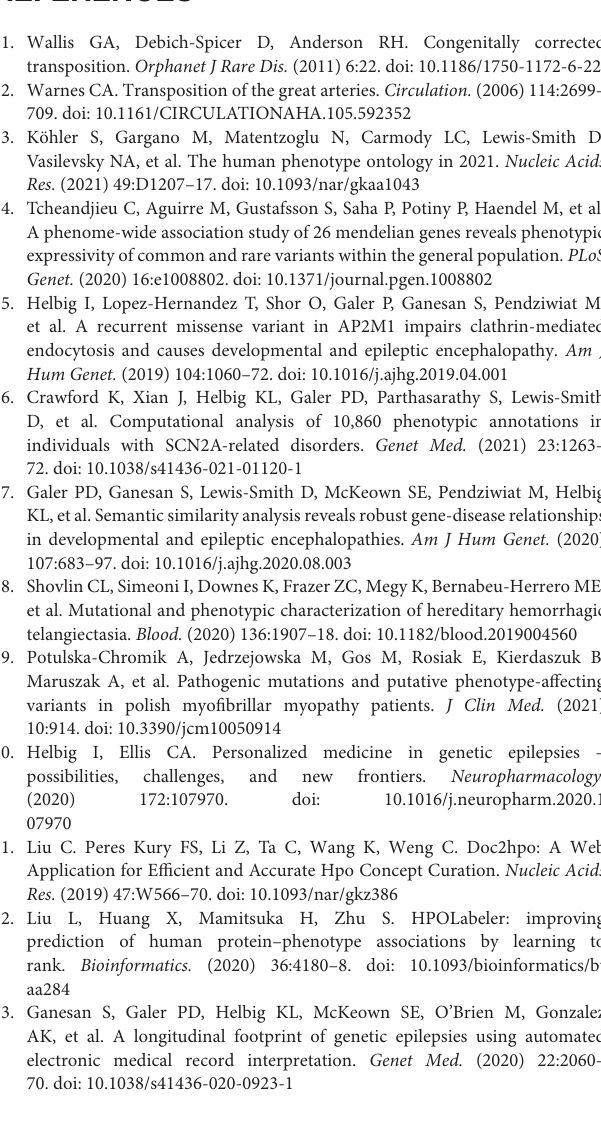
strategies in cluster 1 ( p = 0.95); (B) Freedom from reintervention of different surgical strategies in cluster 3 ( p = 0.064). Shading indicates a 95% CI. Supplementary Figure 7 | Kaplan-Meier analysis of physiological repair group among three clusters. (A) The comparison of survival rate in physiological repair group among three clusters ( p = 0.84); (B) Freedom from composite endpoints in physiological repair among three clusters ( p = 0.21). Shading indicates a 95% CI. Supplementary Figure 8 | Kaplan-Meier analysis of anatomical repair group among three clusters. (A) The comparison of survival rate of anatomical repair among three clusters ( p = 0.74); (B) Freedom from composite endpoints of anatomical repair among three clusters ( p = 0.85). Shading indicates a 95% CI. Supplementary Figure 9 | Kaplan-Meier analysis of Fontan group between cluster 2 and 3. (A) The comparison of survival rate of Fontan procedure between cluster 2 and cluster 3 ( p = 0.21); (B) Freedom from composite endpoints of Fontan procedure between cluster 2 and cluster 3 ( p = 0.65). No patient received the Fontan procedure in cluster 1. Shading indicates 95%